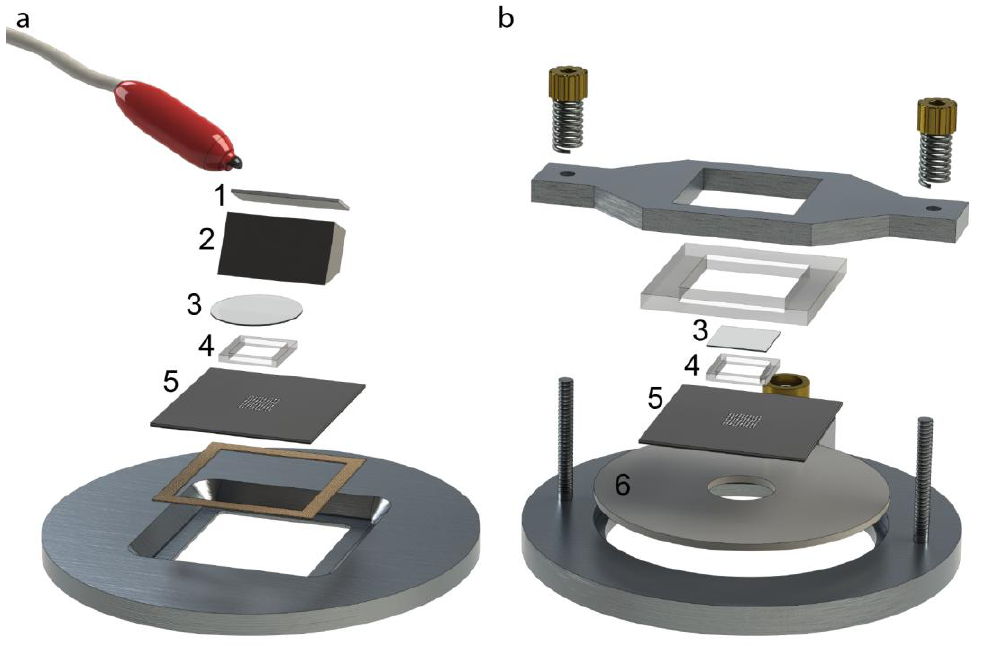
Figure 2. The two different designs of ultrasonic actuation system used for the multi-well microplate: The wedge-transducer device [18] ( a ) and the ring-transducer device [17] ( b ). (1) Piezoceramic plate; (2) Titanium wedge; (3) Glass lid; (4) PDMS frame; (5)